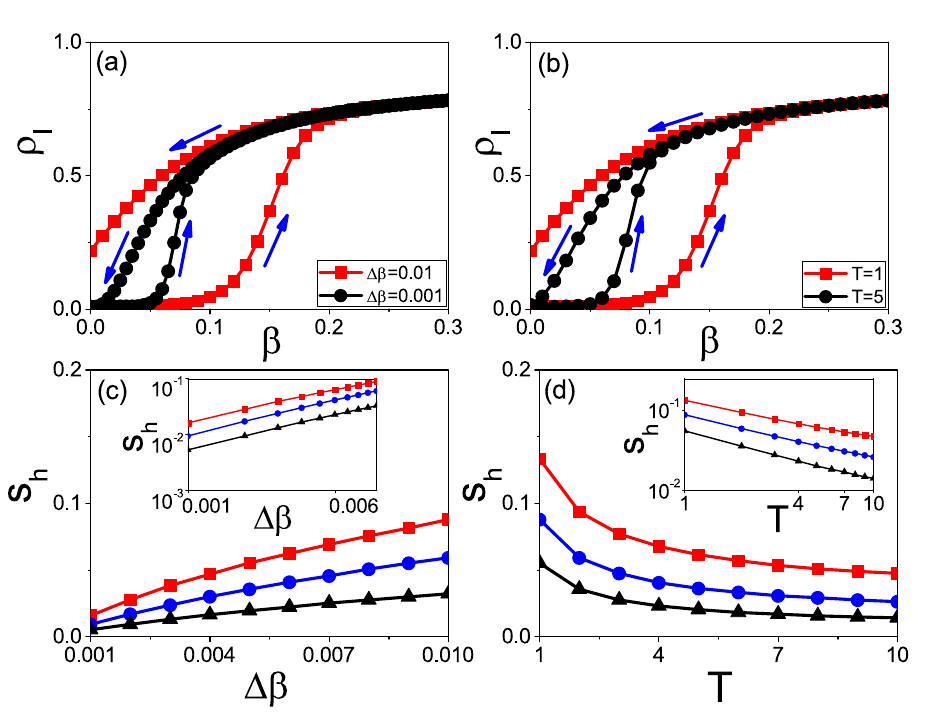
Figure 5. Hysteresis loops in parameter space where ( a–d ) corresponds to Fig. 2(a–d),